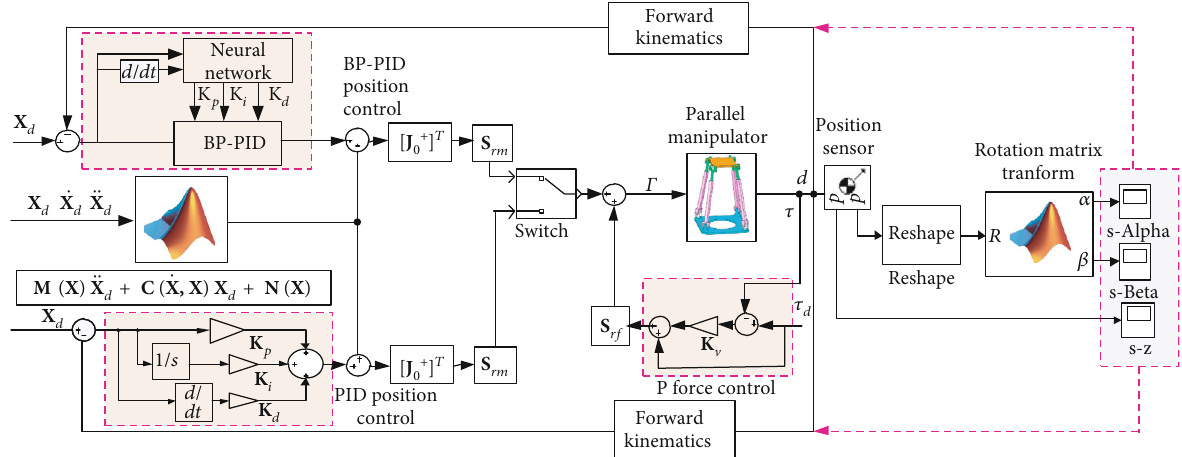
Figure 4: Force/position hybrid control scheme diagram of parallel mechanism with redundant